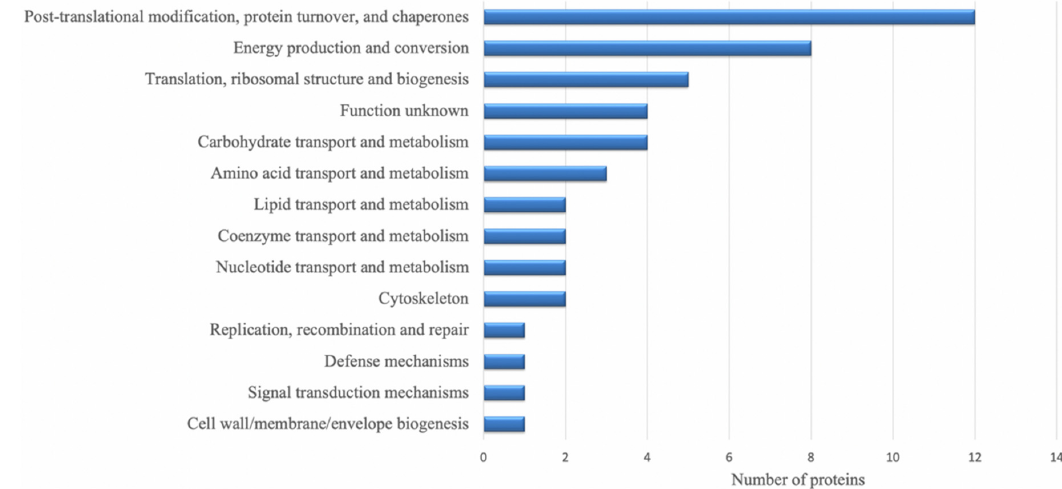
Figure 2. Representation of differently regulated proteins (DRPs) matching with a function in the Cluster of Orthologous Group of proteins (COG) database.